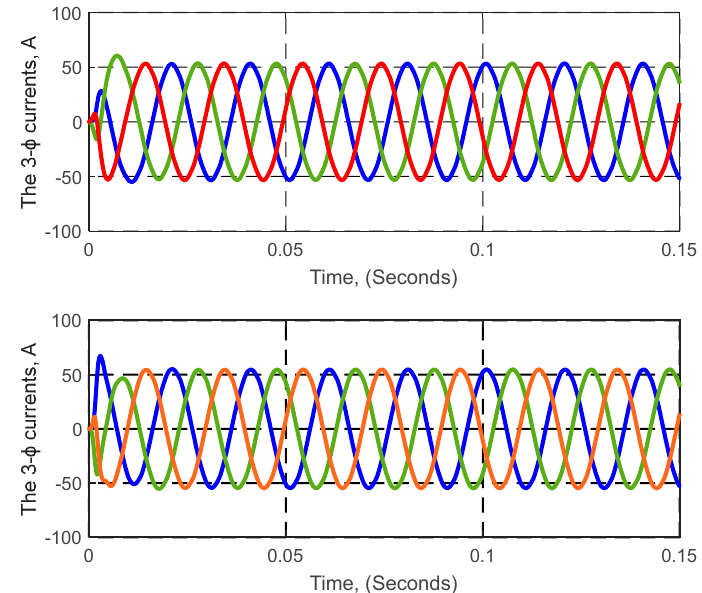
Figure 8. The output currents of both inverters.